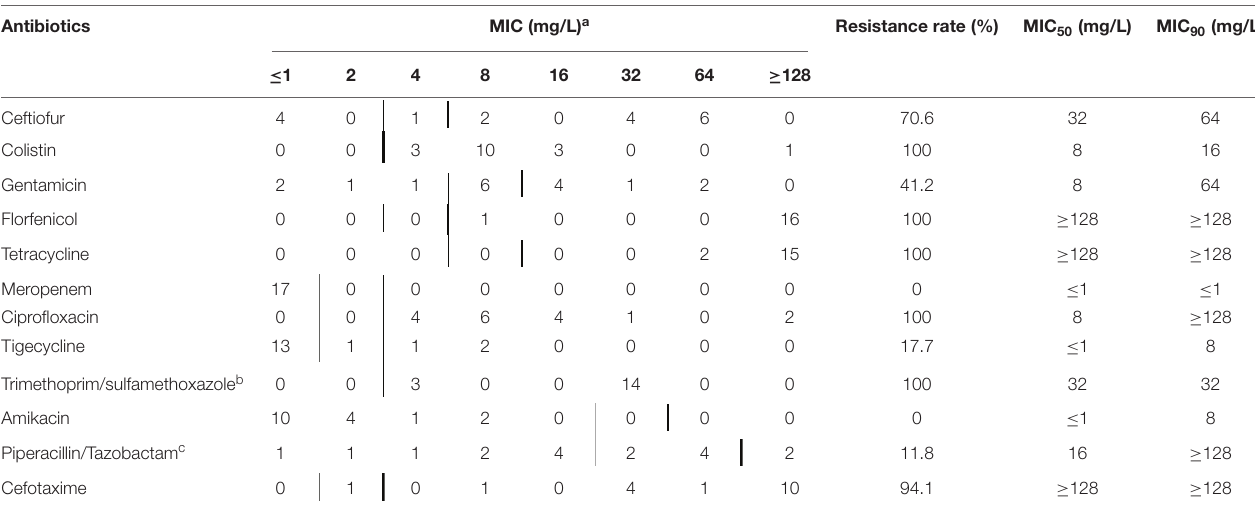
a Thin vertical lines represent the breakpoints between susceptible and insusceptible isolates. Bold vertical lines represent the breakpoints between non-resistant and resistant